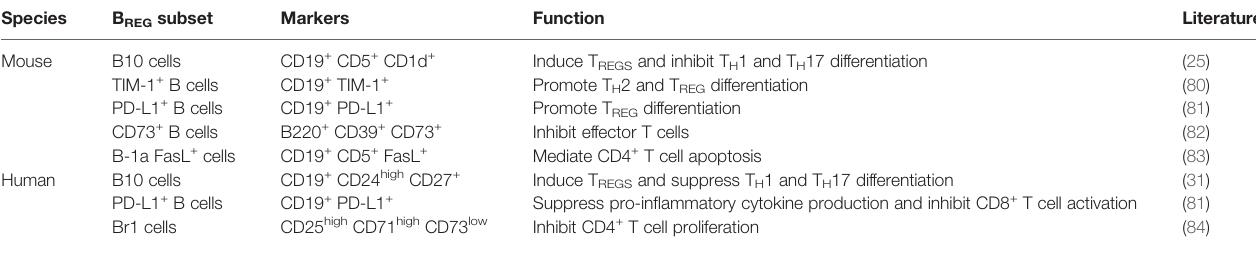
TABLE 2 | Phenotypes and functions of regulatory B cells. Species B REG